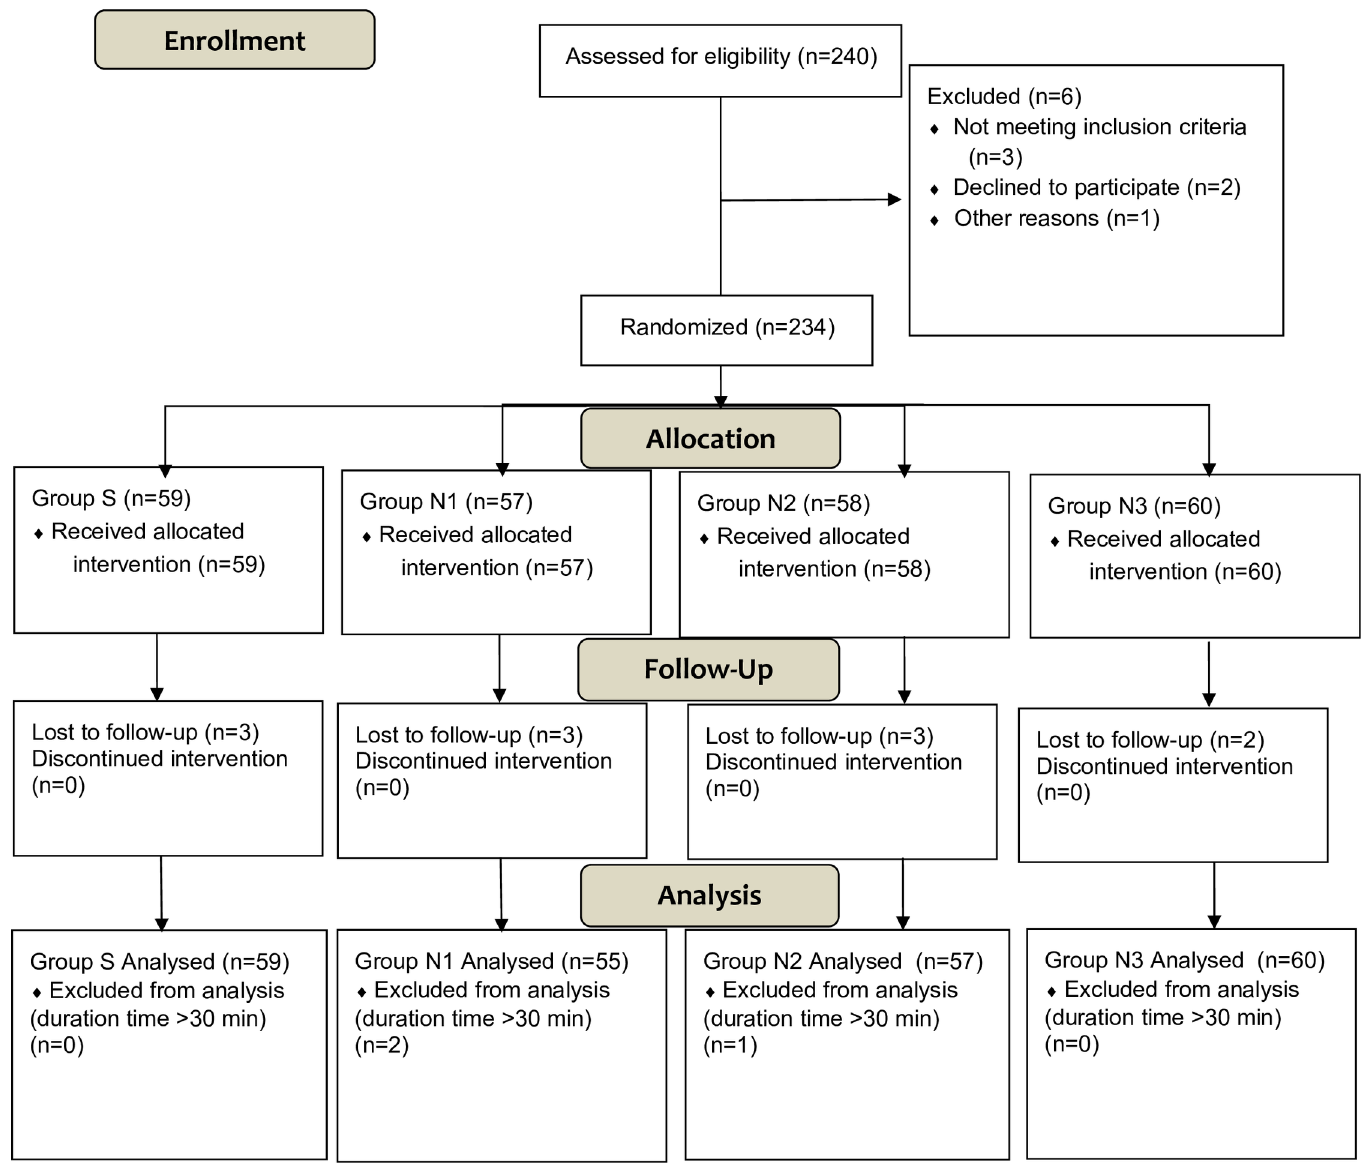
Fig 1. Flow chart showing the study